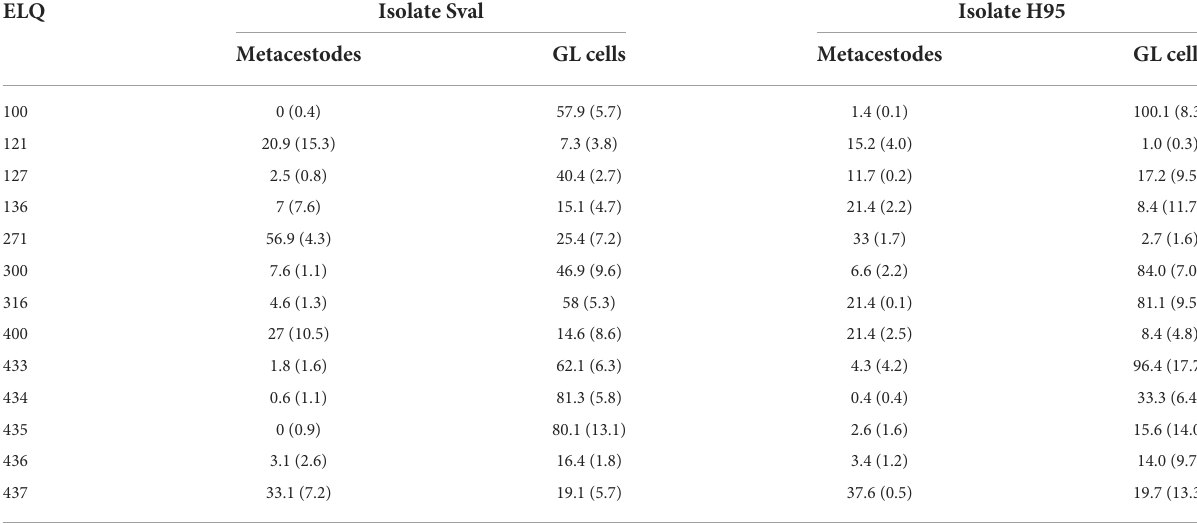
ELQ numbers are given in the first column. The two parasite isolates Sval and H95 were tested. Efficacy against metacestodes was assessed by PGI assay (relative to the positive control Tx-100), and against GL cells by viability assessment via ATP measurements (relative to the DMSO control) in µ M. Compounds were considered to be active, if they reached a threshold